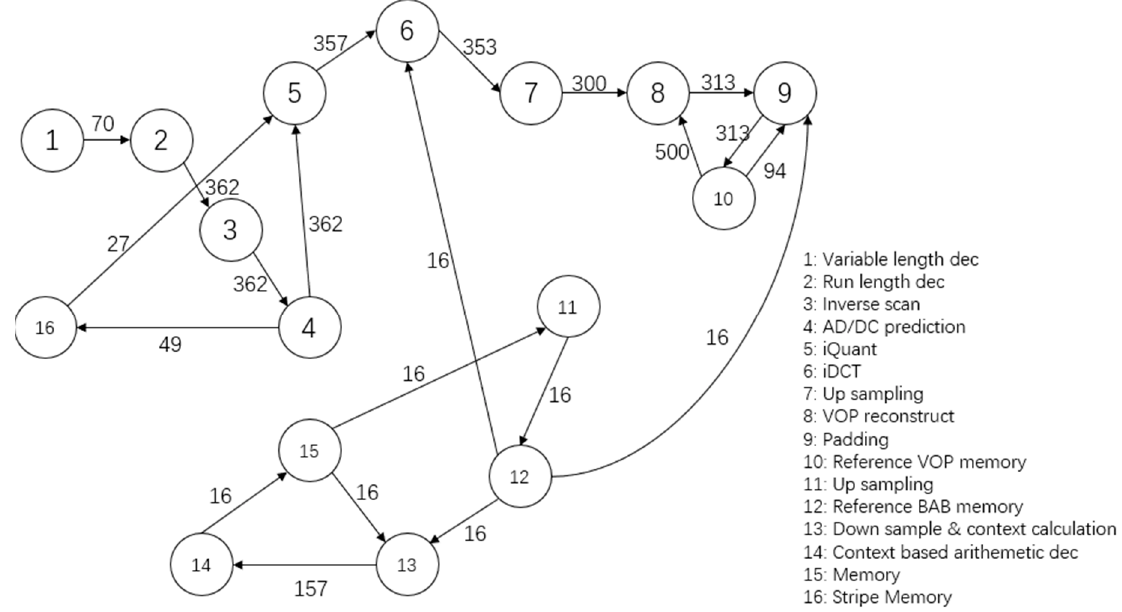
Figure 5. VOPD communication core diagram.